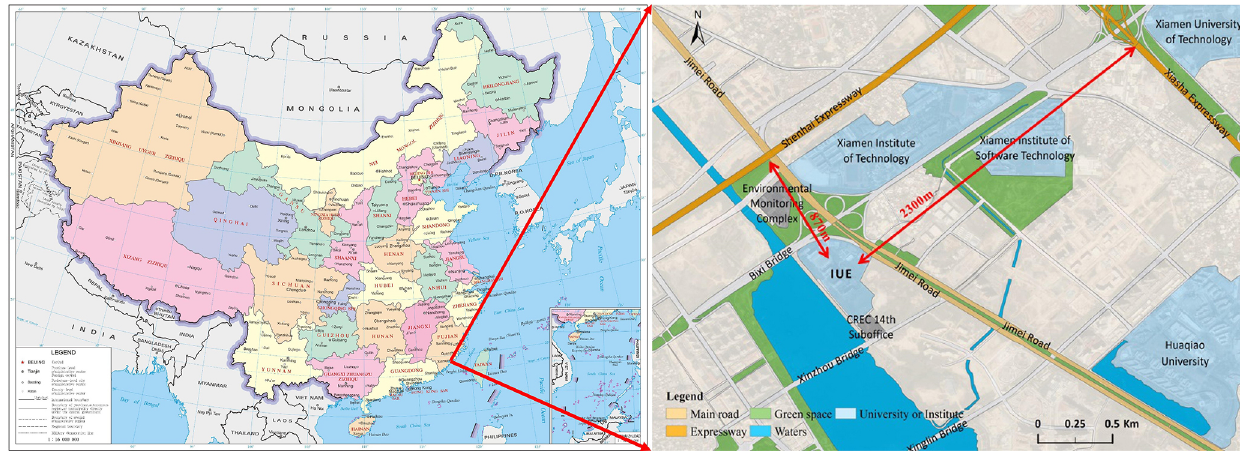
Figure 1. Location of Xiamen in China (left) and surroundings of IUE (right). Note: the map on the left was directly downloaded from http://bzdt.ch.mnr.gov.cn/ (last access: 22 September 2021), while the map in the right was significantly enriched based on a layer download from http://www.rivermap.cn/ (last access: 25 October 2020). The copyright statement of Fig. 1 on the left is © 2021 SinoMaps Press and National Geomatics Center of